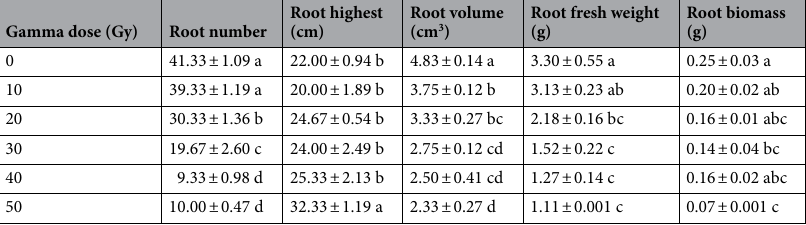
Table 3. The effect of different gamma irradiation doses on root traits in ‘Yaghouti’ grape ( Vitis vinifera L.) cultivar. The means with same Duncan’s multiple range test letters in each column are not statistically significant ( P ≤ 0.01). Data are average of four replications ±